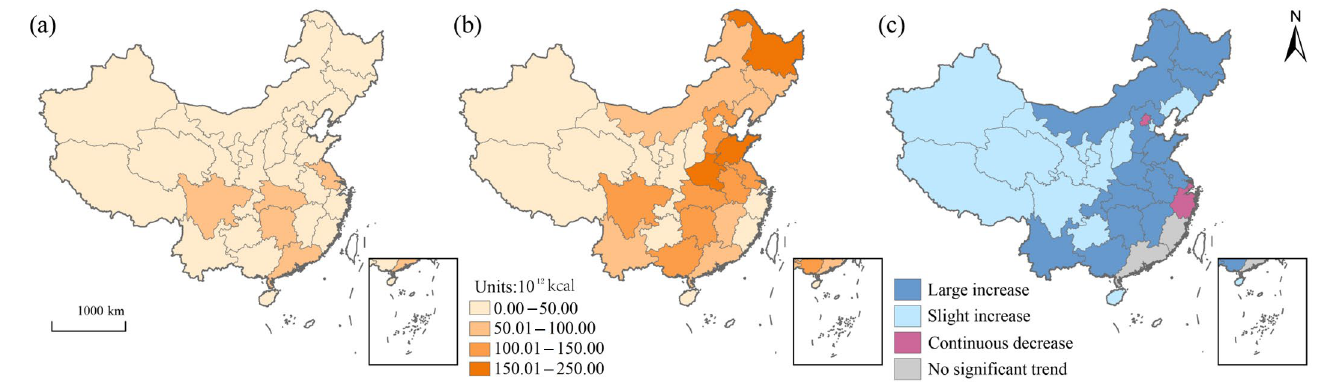
Figure 4. Distribution pattern of food production and classification in China: ( a ) food calorie production pattern in 1978; ( b ) food calorie production pattern in 2020; ( c ) classification of food caloric growth rate from 1978 to 2020.